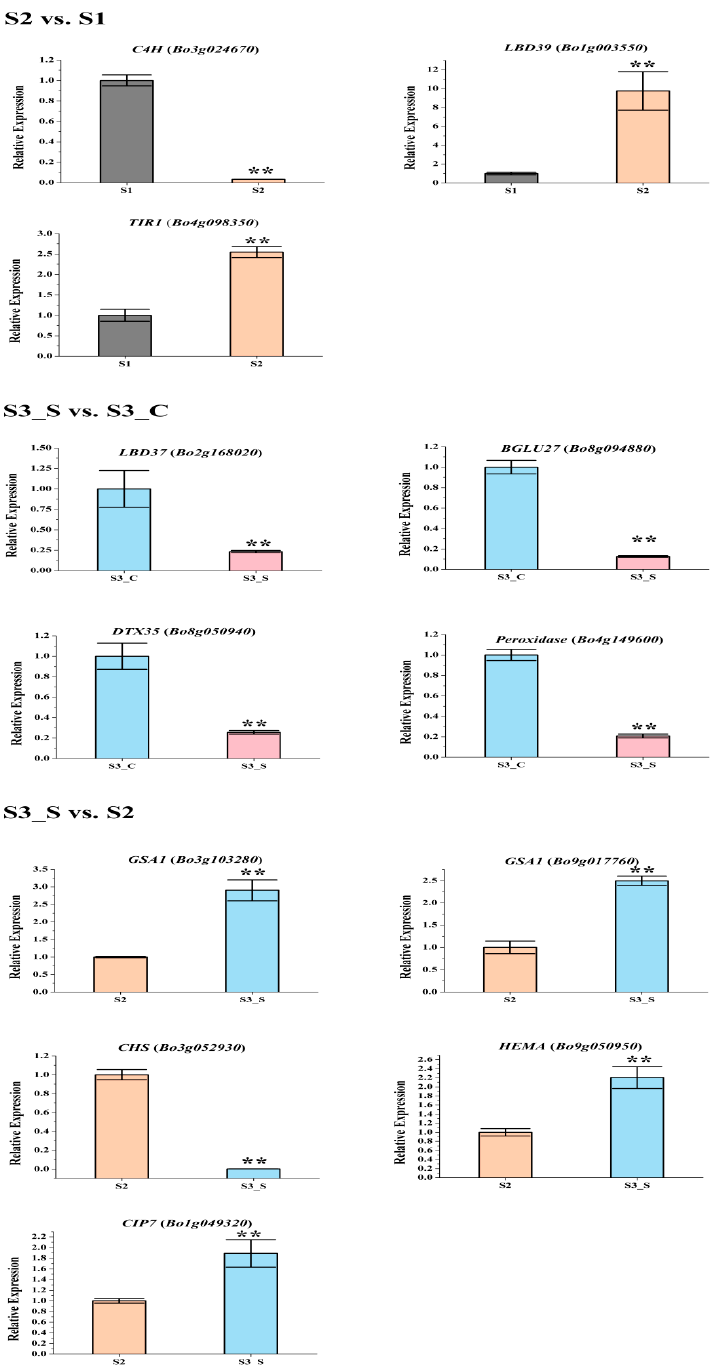
Figure 7. Expression levels of the differentially expressed genes (DEGs) related with anthocyanin biosynthesis, anthocyanin degrading and chlorophyll biosynthesis in the three pairwise comparisons. Only DEGs with reduction in S3_S vs. S3_C were tested. Data are represented as the mean ± standard deviation (SD). ** p < 0.01 using the